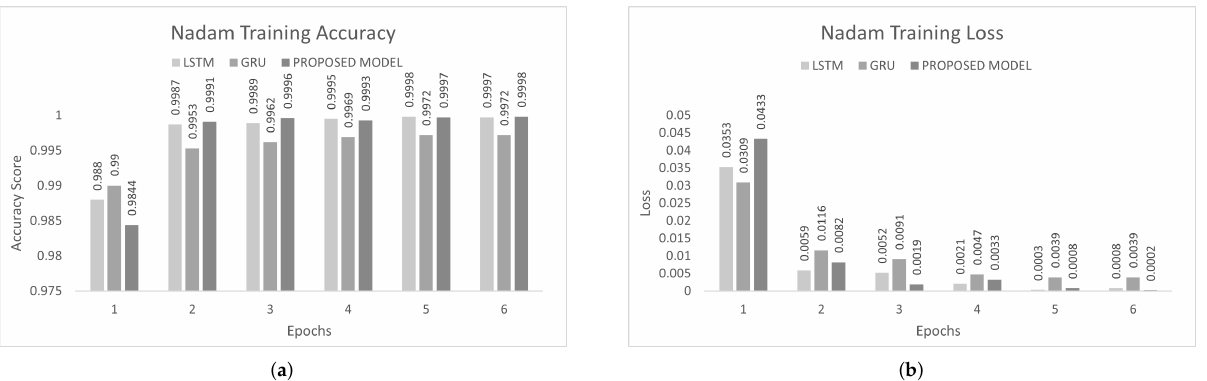
Figure 18. Nadam Training on the car-hacking dataset. ( a ) Nadam training accuracy on car-hacking. dataset; ( b ) Nadam training loss on car-hacking. dataset.